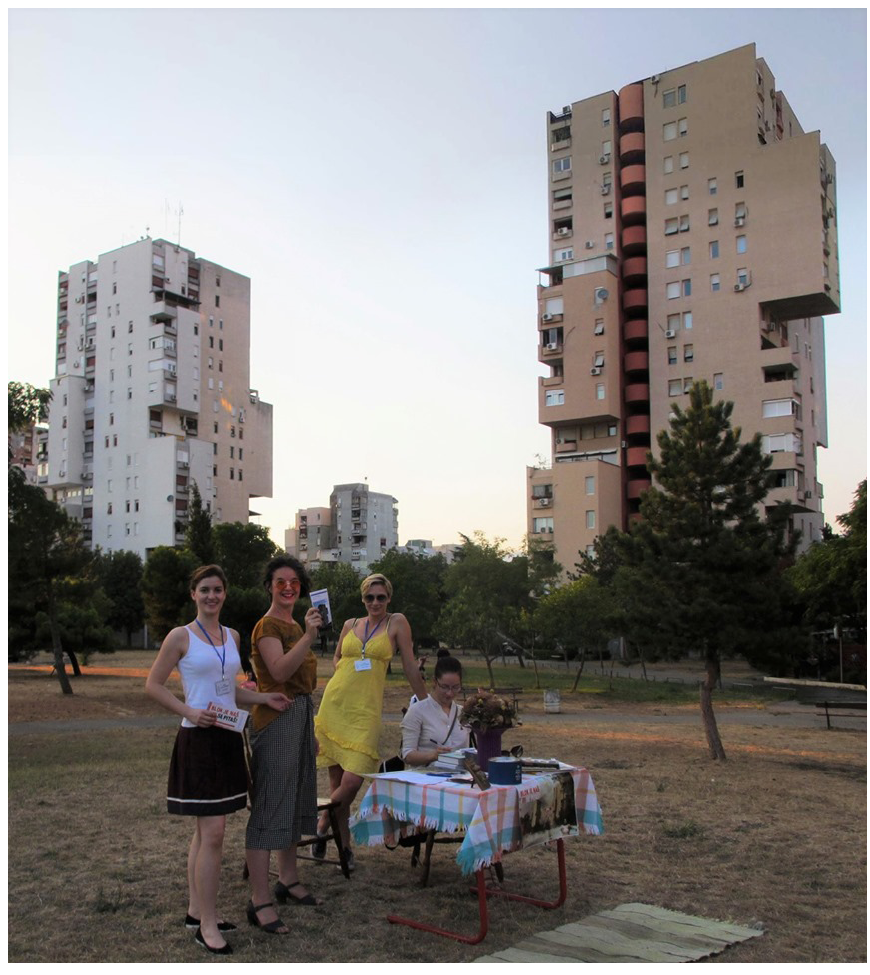
Fig. 12 Pop-up information point established in Blok 5 by members of the NGO KANA, 2017. (Source: KANA private